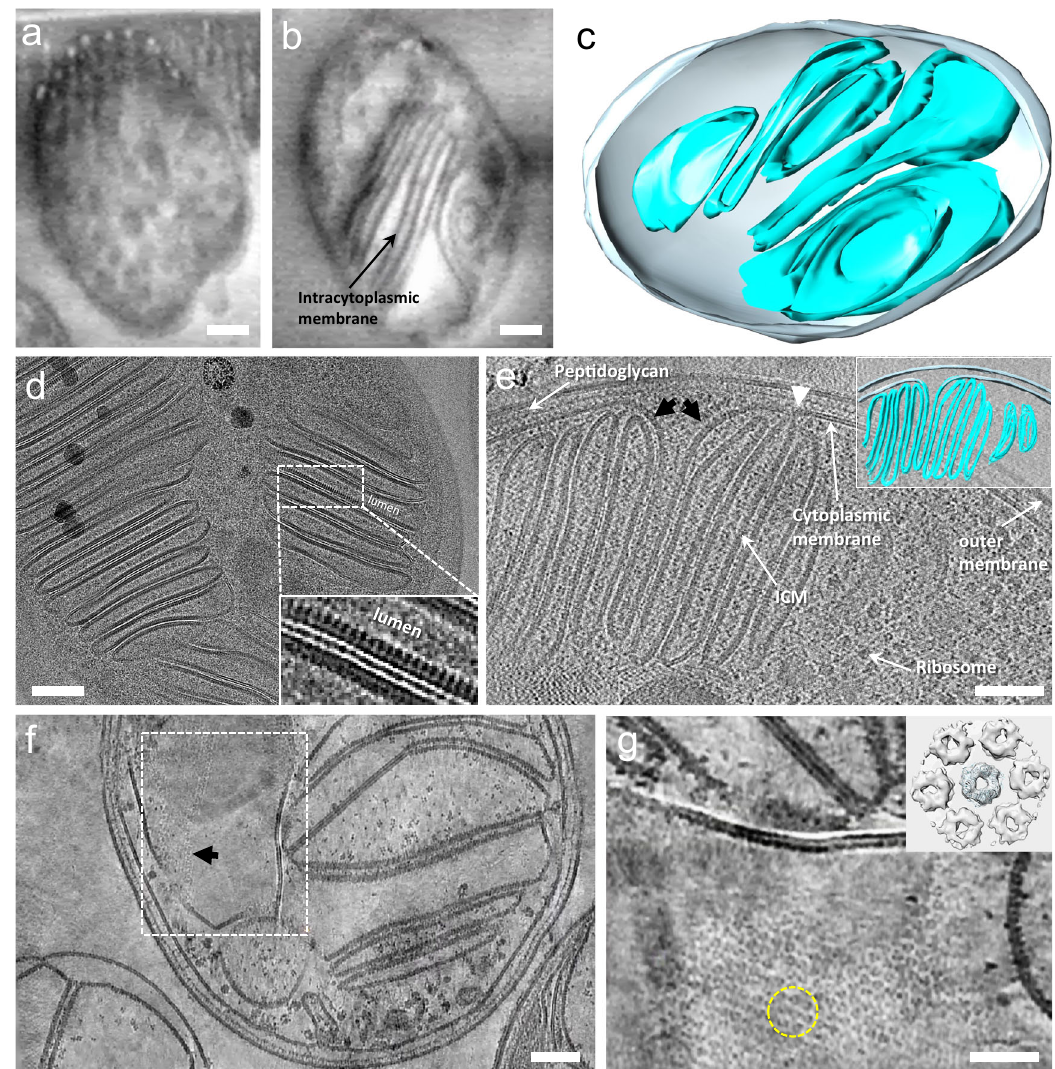
Fig. 1 | Copper-induced ICMs of methanotrophic bacteria. a, b Representative slices from serial cryoFIB/SEM volumes of M. capsulatus (Bath) cultured in a med- ium containing 0 μ M ( a ) or 25 μ M (b) CuSO 4 . For ( a ), similar volume images were conducted in fi ve independent experiments. For ( b ), similar volume images were conducted in ten independent experiments. c Membrane segmentation of the cell in ( b ).Cellmembraneisshownin grey, andICMsare shownincyan. d Aprojection image of cryoFIB lamella of M. capsulatus (Bath) cultured in the copper-containing medium (from n =20). Inset, enlarged view of boxed area, displaying comb-like edge-on view of membrane-bound protein arrays. e An 8.5nm thick tomographic